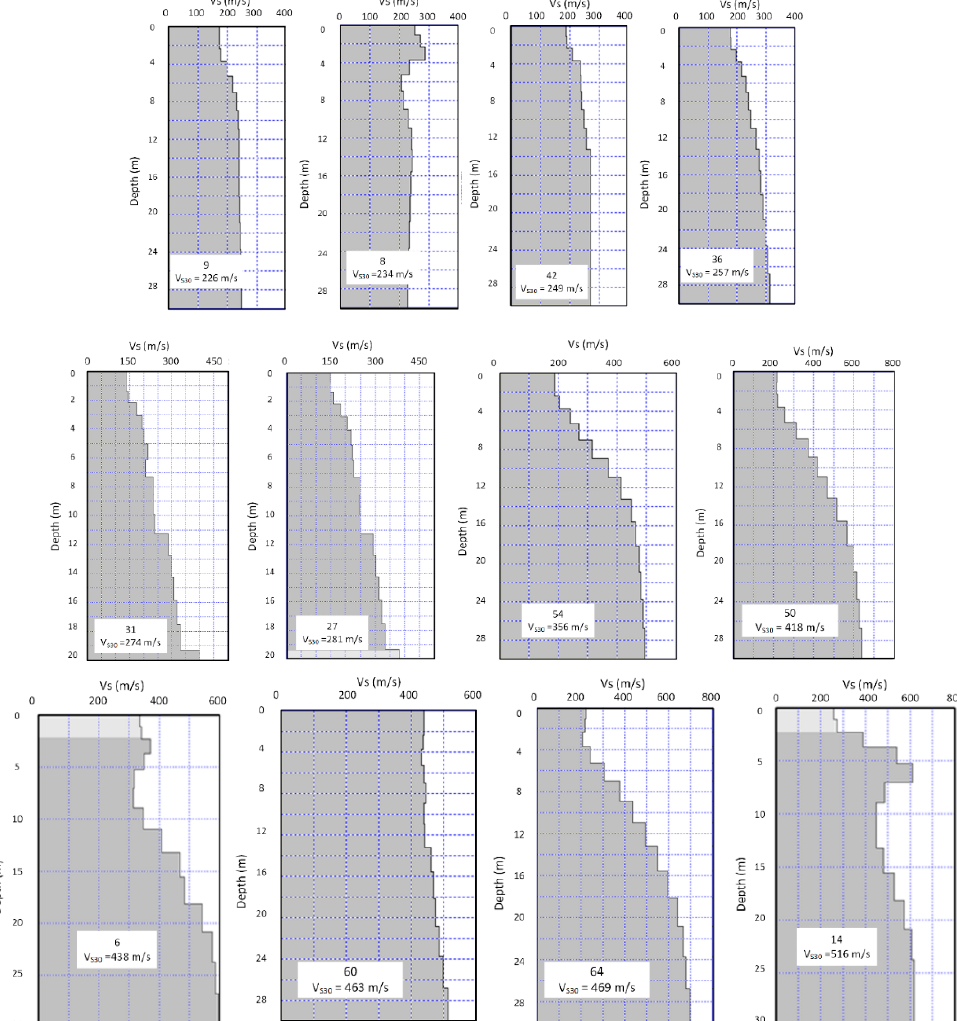
Figure 7. 1-D shear wave velocity profiles derived from MASW measurements with estimated values of V S30 . Note that profiles for sites 27 and 31 didn’t reach depth of 30 m as other sites due to very low surface shear wave